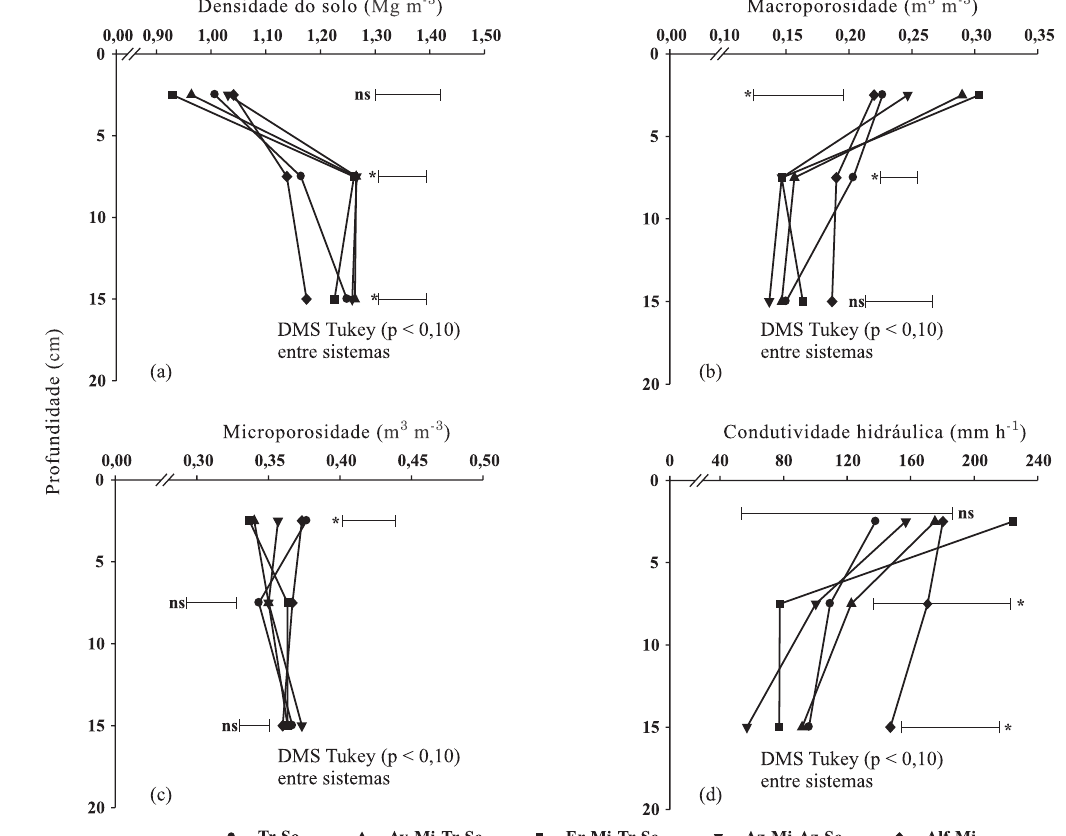
Figura 1. densidade do solo (a), macroporosidade (b), microporosidade (c) e condutividade hidráulica saturada (d) de um latossolo Vermelho sob sistemas de culturas em plantio direto, nas camadas de 0–5, 5–10 e 10–20 cm. tr-so: trigo-soja; av-Mi-tr-so: aveia-milho-trigo-soja; er-Mi-tr-so: ervilhaca- milho-trigo-soja; az-Mi-az-so: azevém-milho-azevém-soja; alf-Mi: alfafa-milho. Barras horizontais representam a diferença mínima significativa pelo teste de tukey (p < 0,10) (ns: não significativo; *: significativo a 10